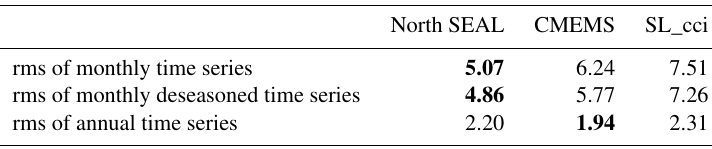
Figure 7. Correlations between sea level variations from three different altimetry products and TG measurements depending on TG location category. Table 3. Comparison of sea level variability from altimetry (for North SEAL, CMEMS, SL_cci) and 52 TGs over 1996–2015. Differences between altimetry and TGs are provided in terms of median rms in centimeters. The best altimetry solution in each case is marked in bold. All time series are corrected for datum differences, and trends are